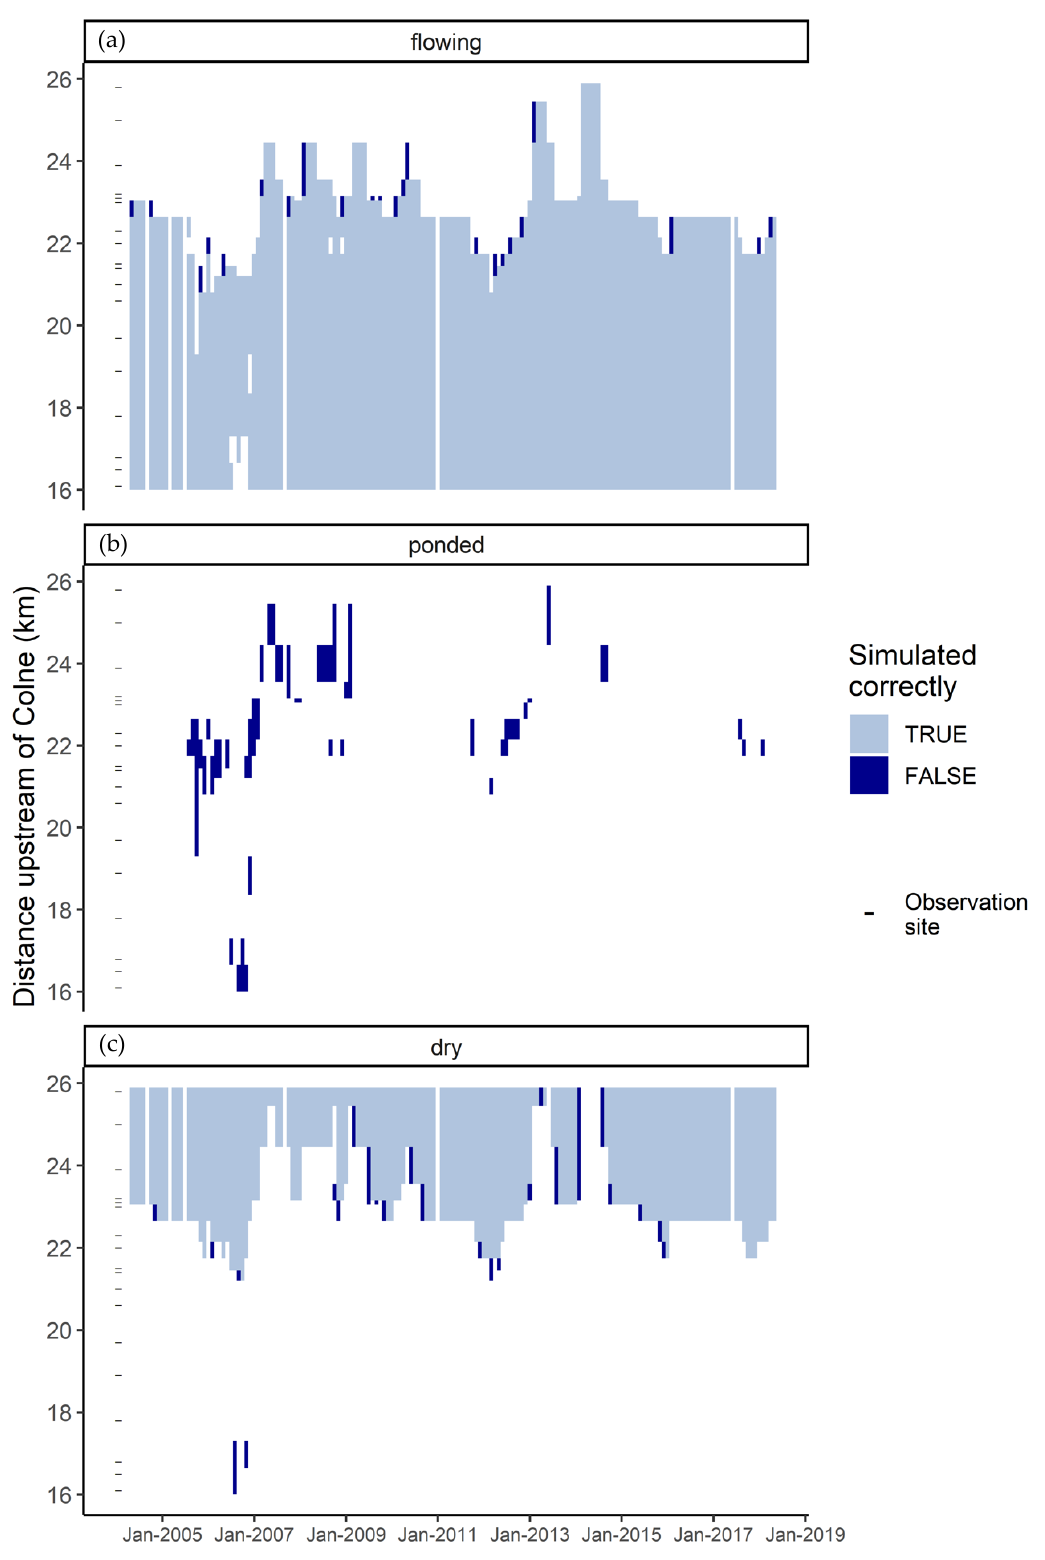
Figure 5. Monthly time series indicating whether flowing ( a ), ponded ( b ), and dry ( c ) states were simulated correctly and when and where the states were observed on the Gade. Hydrological state is assumed to be consistent along observed reaches due to the high spatial resolution of the data.